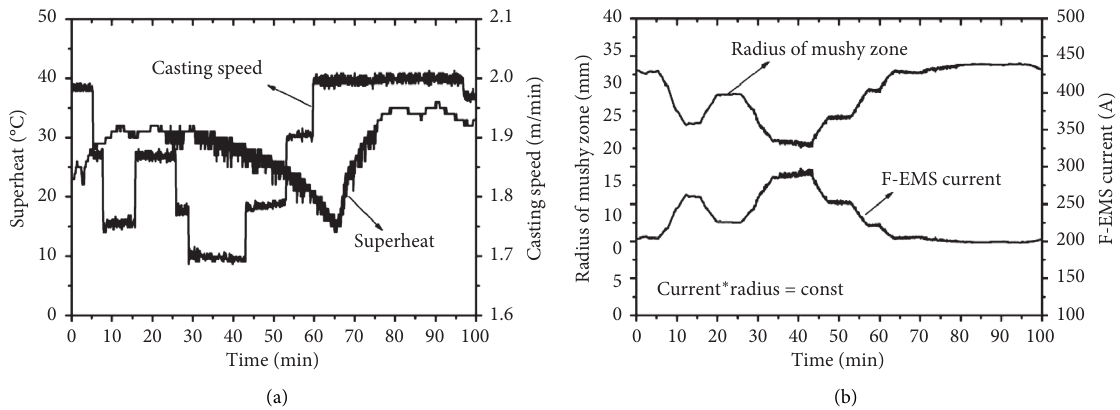
Figure 7: Dynamic control of F-EMS. (a) The casting conditions including pouring superheat and casting speed. (b) The radius of the mushy zone at F-EMS installation position and F-EMS current as functions of Table 3: Distribution of billet internal defects. Defect Porosity levels